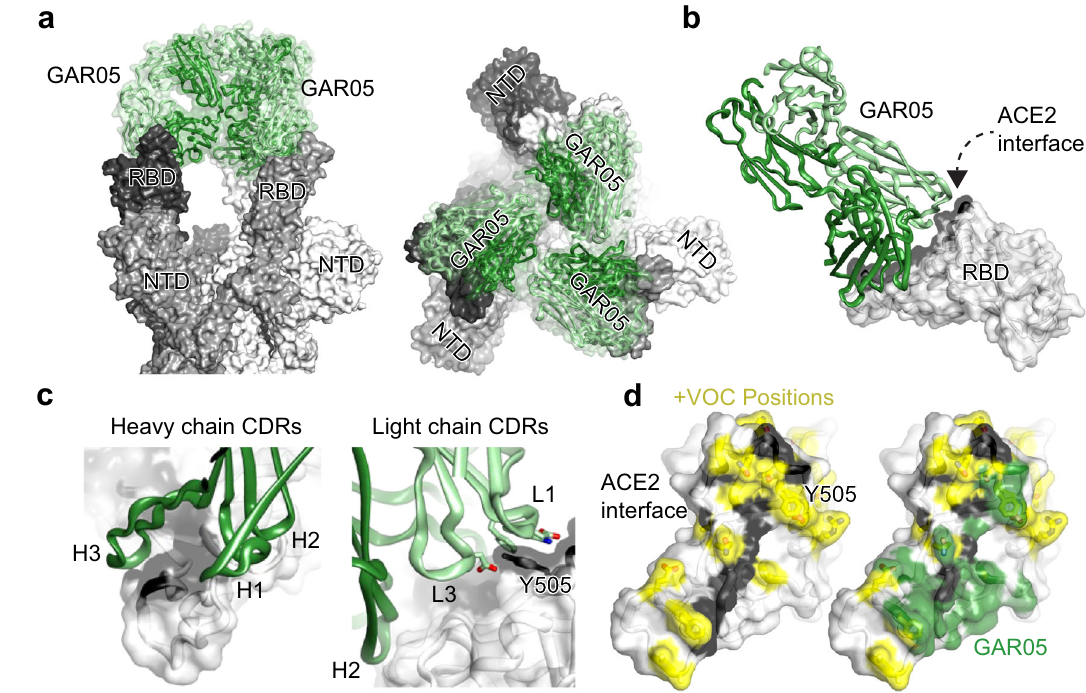
Fig. 2 | Structural characterization ofthe broadlyneutralizing class 1 antibody GAR05. a Cryo-EM structure of GAR05 Fab bound to trimeric spike (3.27Å reso- lution) showing full antibody Fab occupancy of all the RBDs in the “ up ” con- formation.Twoperspectivesareshown b StructureofGAR05bound toSARS-CoV- 2 RBD based on the X-ray crystal structure, outlining the antibody bound to the ACE2 “ saddle ” of the RBD (ACE2 interface shaded black). c Interaction of the CDR